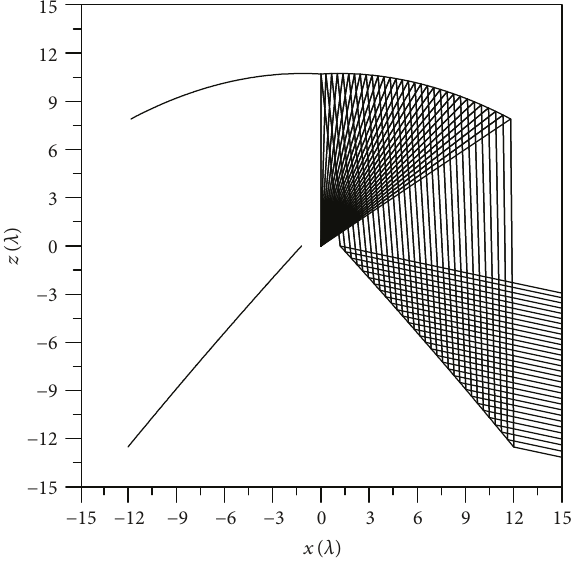
Figure 6: MoM/MMT and CST radiation patterns of the classical ADE antennas.